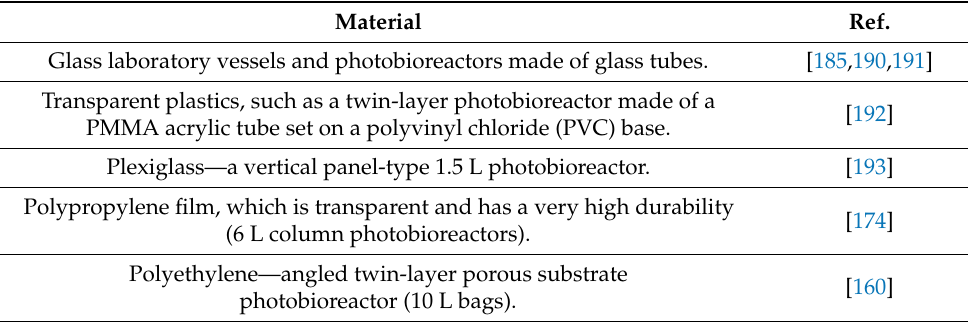
Table 13. Typical transparent materials used for bioreactor